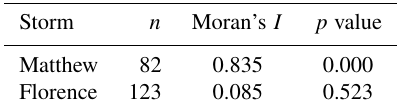
Table 3. Moran’s I statistic and associated p value for (cid:49)t ps-lf for hurricanes Matthew and